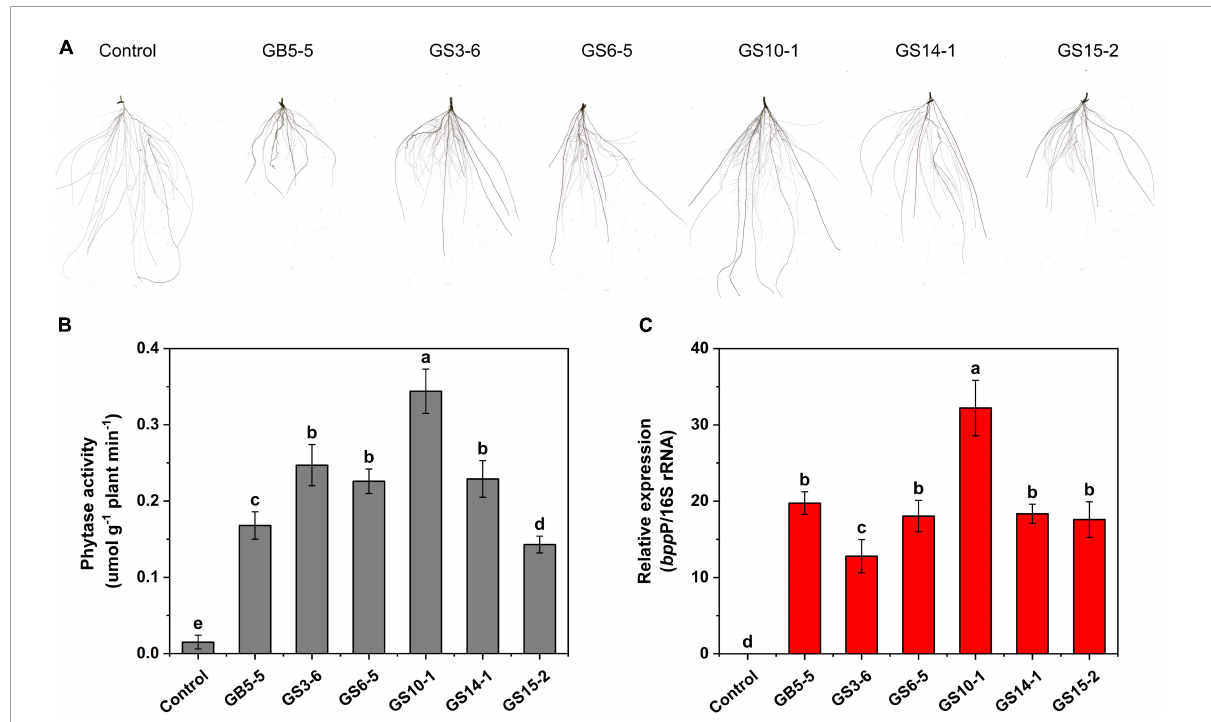
FIGURE4 Effect of strains inoculation on Lolium perenne L. root system after 28 days for (A) root morphology, (B) root system phytase activity, and (C) phytase gene ( bpp P) relative abundance. Control: root system of uninoculated strains. Each value is a mean ± SD of three independent trials.